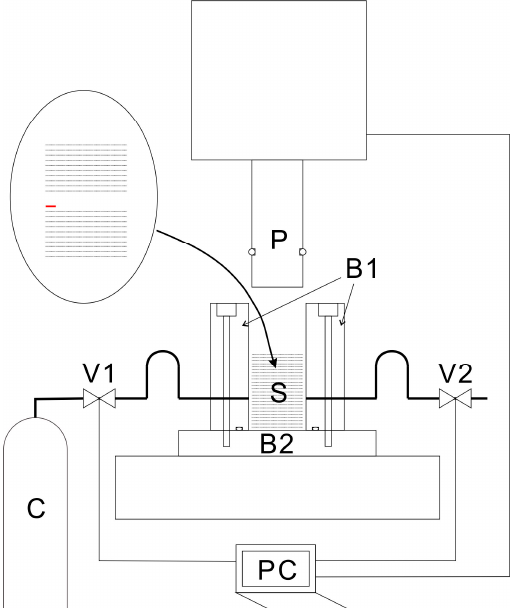
Figure 8. Schematic of a cross-section of the high-pressure vessel. B1: body of the high-pressure vessel; B2: base of the high-pressure vessel; C: CO 2 cylinder; P: piston; PC: laptop computer; S: sample; V1: intake valve; and V2: exhaust valve.